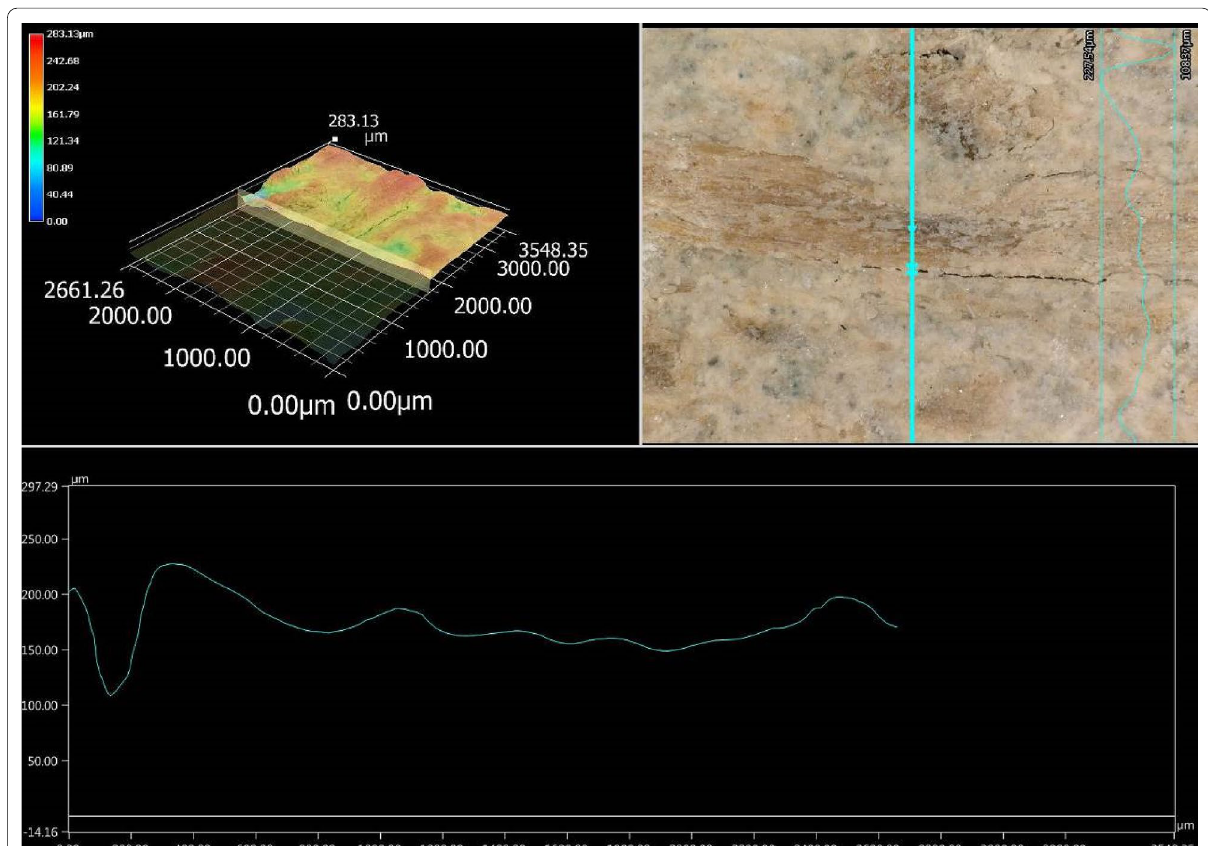
Fig. 20 Structure of REF boards—detailed evaluation of structure with analysis of relief of the surface after 5th wet–frost–dry